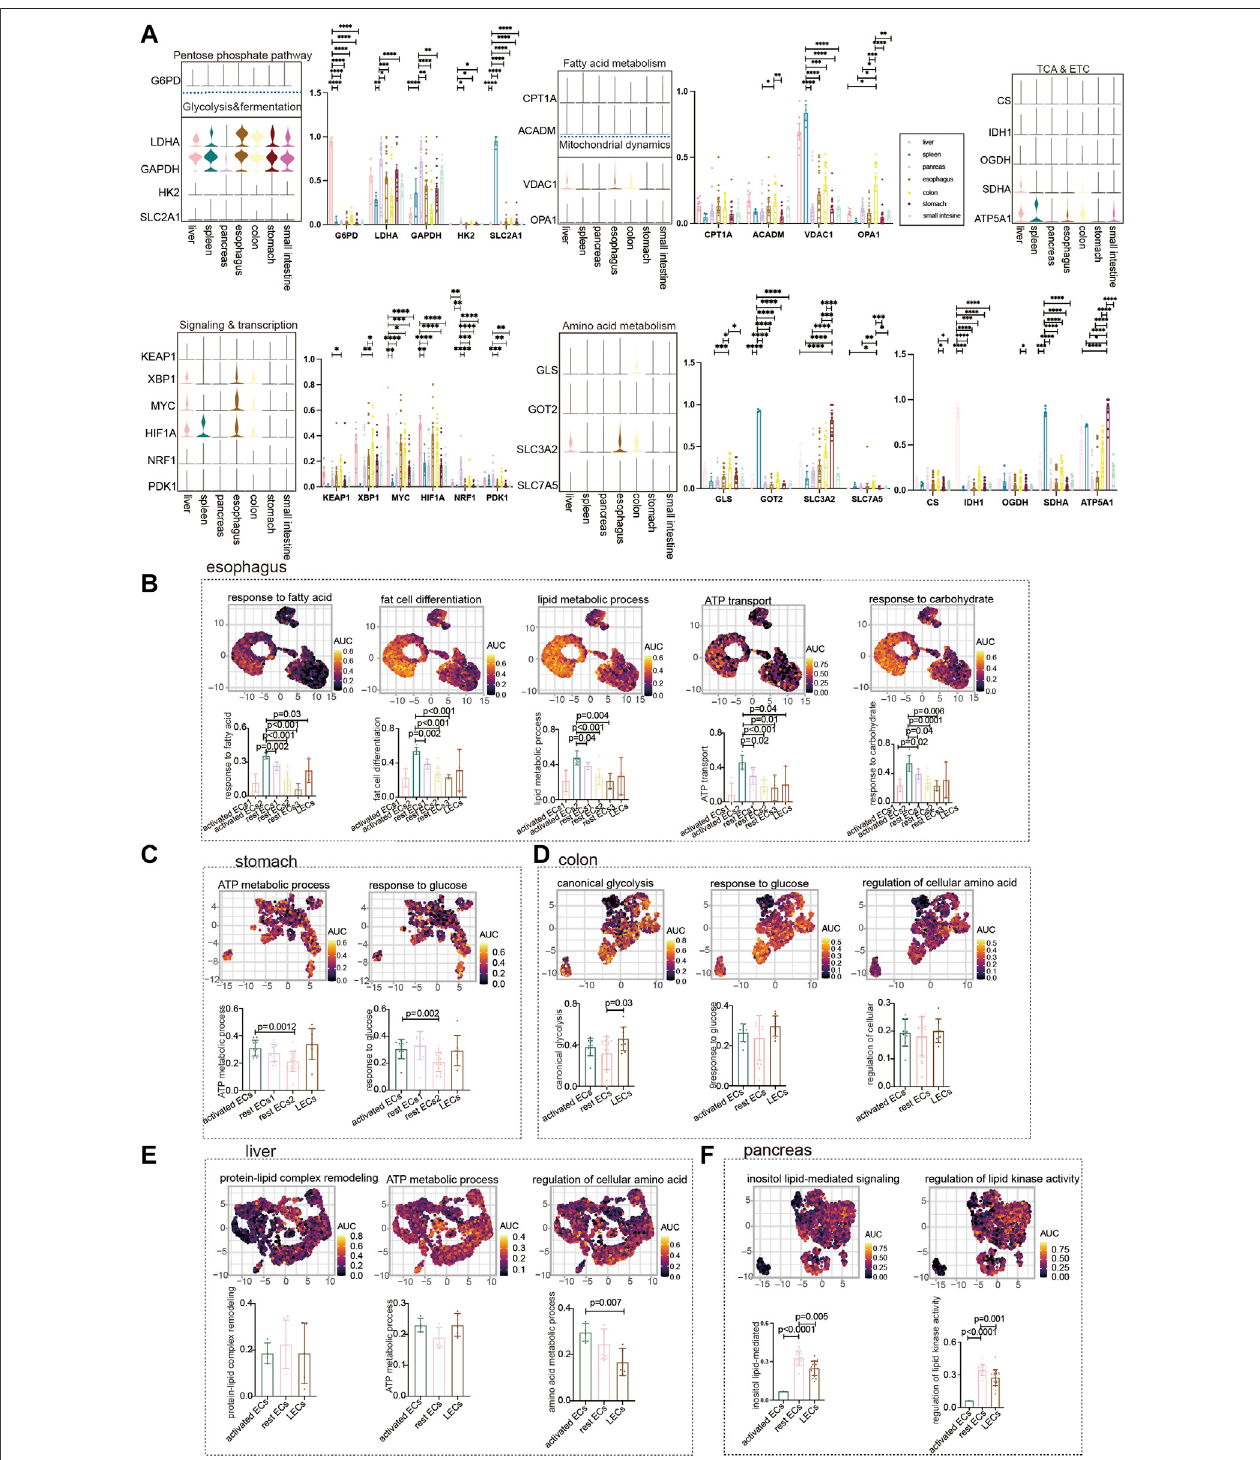
FIGURE2| MetabolismofECsinnormaldigestiveorgans. (A) ViolinplotdemonstratingtheexpressionofmetabolicregulatorsinECsofdifferenttissues.Statistical analysis revealed the proportion of cells positive for metabolic regulators in ECs of different tissues. (B) GO analyzed the enrichment of esophageal EC marker genes to metabolism-related signaling pathways ( “ response to fatty acid, ” “ fat cell differentiation, ” “ regulation of lipid metabolic process, ” “ ATP transport, ” and “ response to carbohydrate ” ).UMAPshowsthedistributionofAUCscoresofpathway-relatedgeneclustersforindividualcells.ThestatisticalanalysisrevealedthatactivatedECs were signi fi cantly enriched to metabolic gene pathways compared to other cell populations. (C) GO analysis of stomach EC marker genes enriched to metabolism-